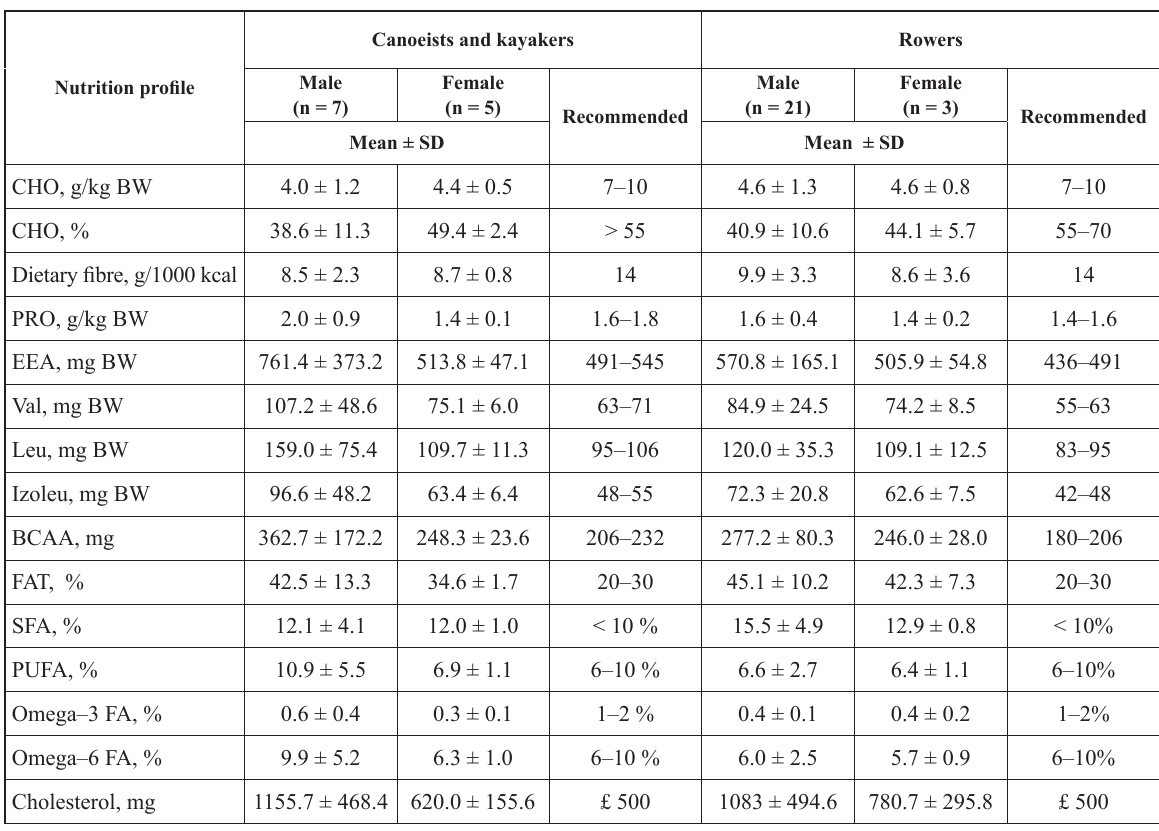
Table 4. Dietary intake of Lithuanian Olympic team canoeists, kayakers and rowers